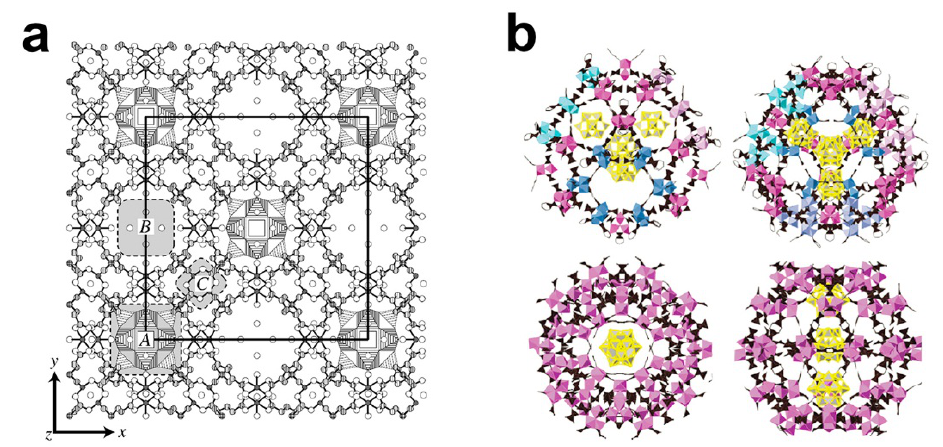
Figure 1. The common connection modes of metal-organic coordination complexes and the representative structures of the organic–inorganic hybrid POM compounds.